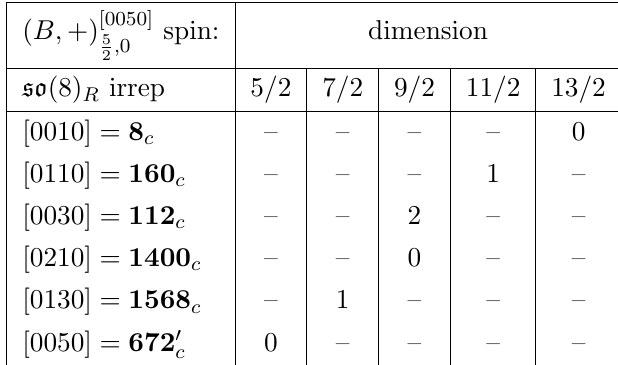
Table 12 . All possible conformal primaries in S 2 (cid:2) S 3 corresponding to the ( B; +) [0050] formal multiplet.